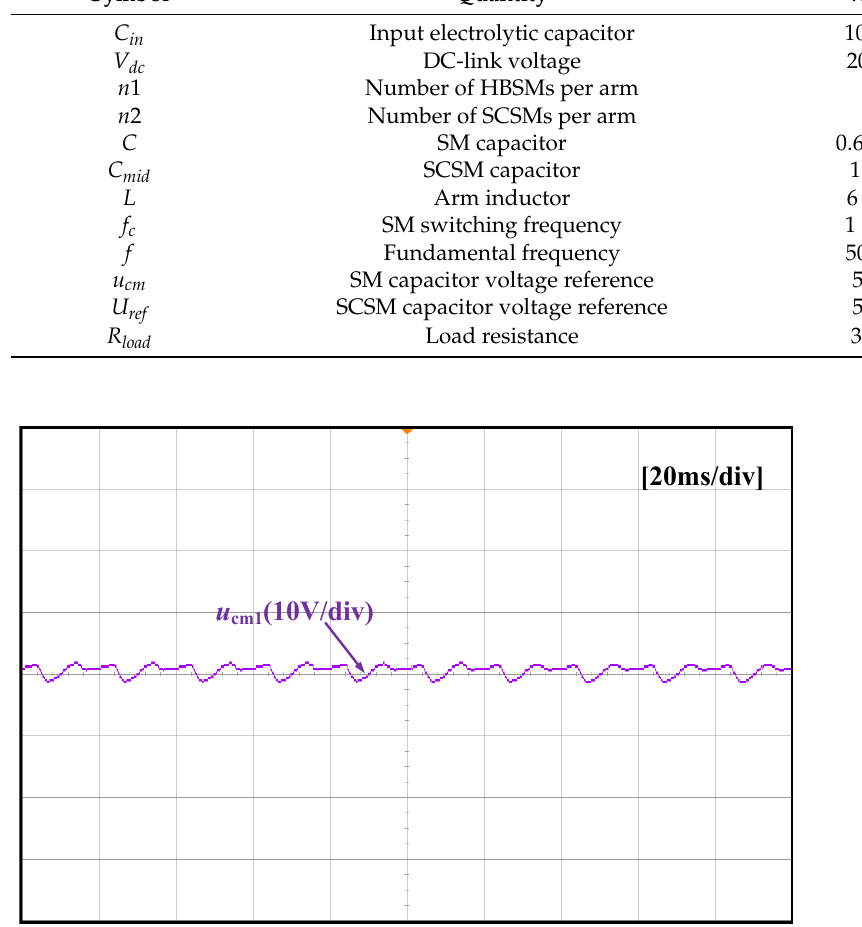
Figure 32. Experimental results of the HBSM capacitor voltage.